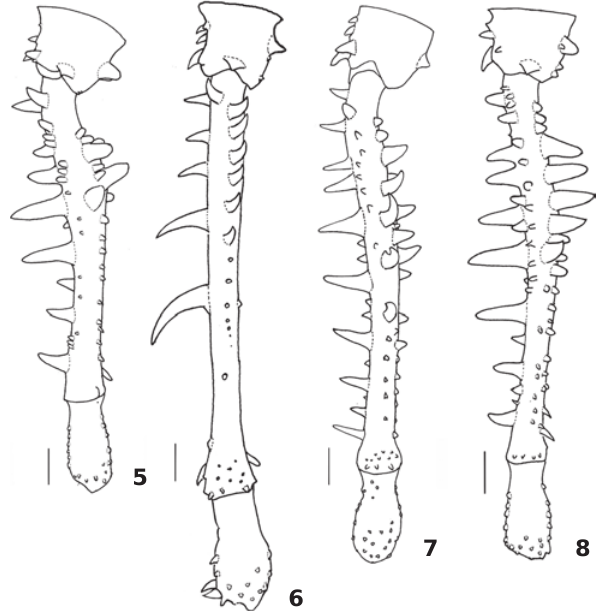
Figures 5-8. Male femora of Parampheres , dorsal view: (5) P. bimaculatus , MCNRS0726; (6) P. lucidus , MCNRS1615; (7) P. tenebris sp. nov.